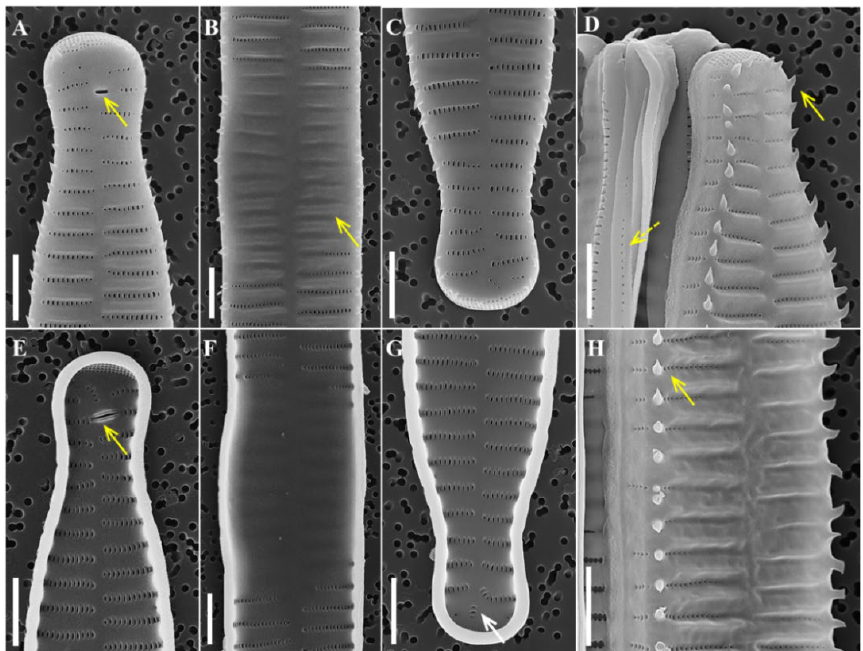
Figure 3. SEM of Hannaea librata sp. nov. taken from holotype population (AG9001), scale bar = 2 µm: ( A ) external view of apex with rimoportula (arrow); ( B ) external view of central area, ghost strain (arrow); ( C ) external view without rimoportula; ( D ) external view of one side showing valve apices with spines, conical shape (solid arrow), girdle band (dotted arrow); ( E ) internal view of apex with rimoportula (arrow); ( F ) internal view of central area; ( G ) internal view of apex without rimoportula, vertical striae (arrow); ( H ) external view of central area with spines, conical shape